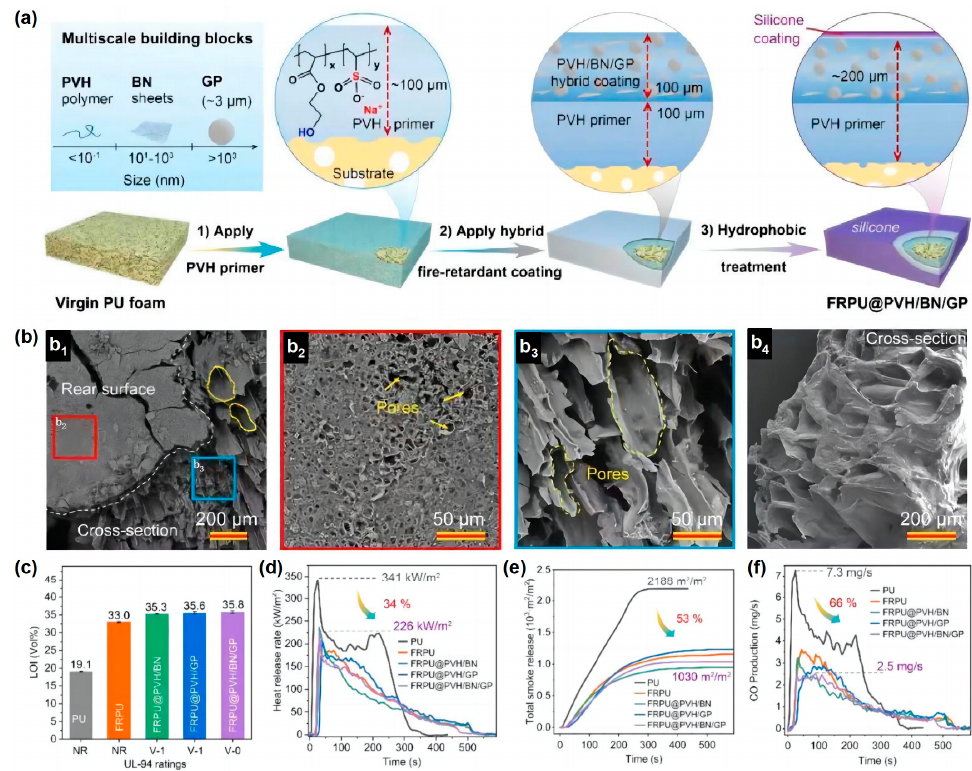
Figure 7. ( a ) The scheme of the manufacturing process of FRPU@PVH/BN/GP; ( b ) porous structure of char layer; ( c ) LOI value of neat RPUF and coated RPUF; ( d ) HRR, ( e ) TSR, and ( f ) CO curves in cone calorimetry test [36].